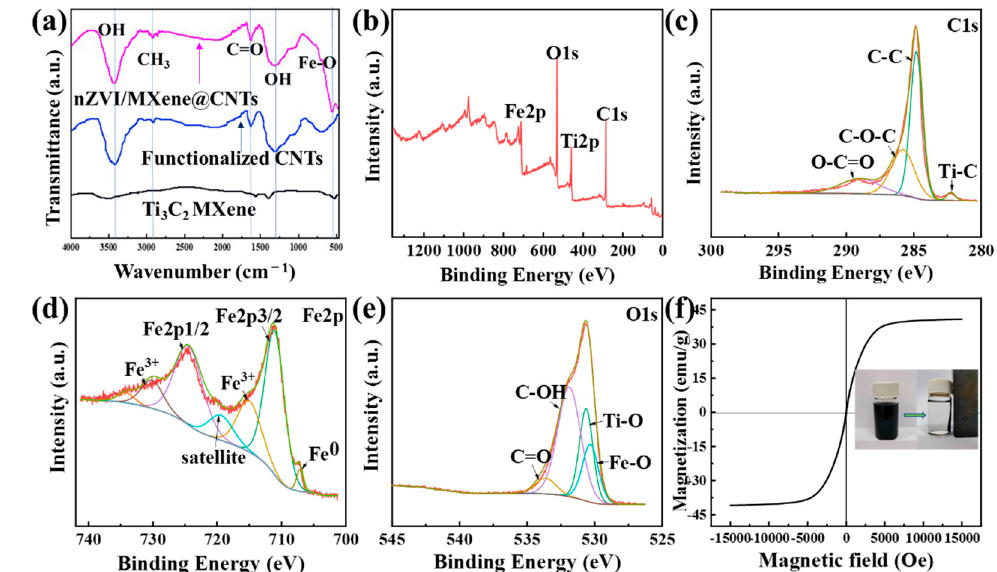
Figure 3. ( a ) FTIR spectra of Ti 3 C 2 MXene, functionalized CNTs and nZVI/MXene@CNTs; ( b ) XPS survey spectra of nZVI/MXene@CNTs; ( c ) C 1s; ( d ) Fe 2p; ( e ) O 1s; ( f ) VSM spectra of